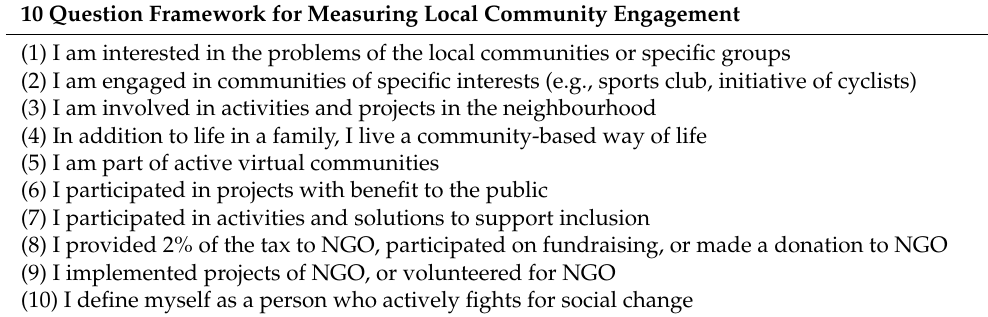
Table A4. 10-question framework for investigation of civic